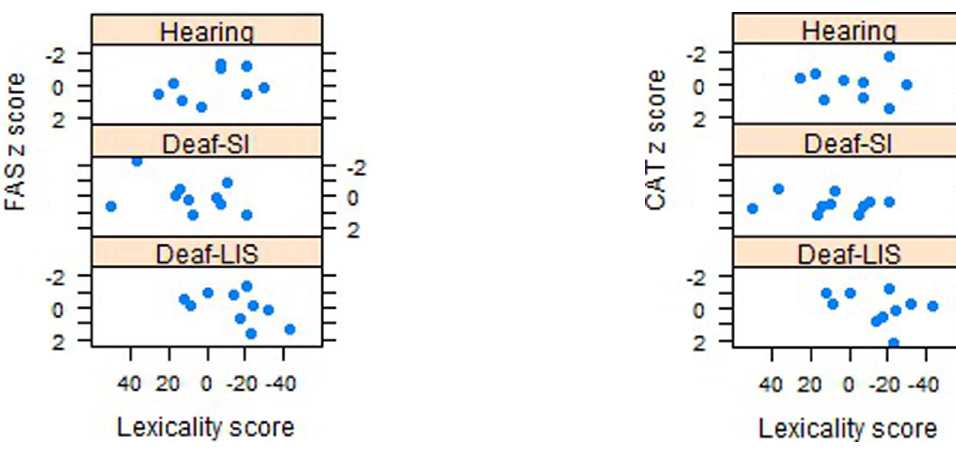
Figure 3. Lexicality effect and semantic fluency task. Scatterplot depicting the mean number of correct responses for each participant within groups (CAT z score), plotted against reaction time difference score between words and consonant strings (Lexicality